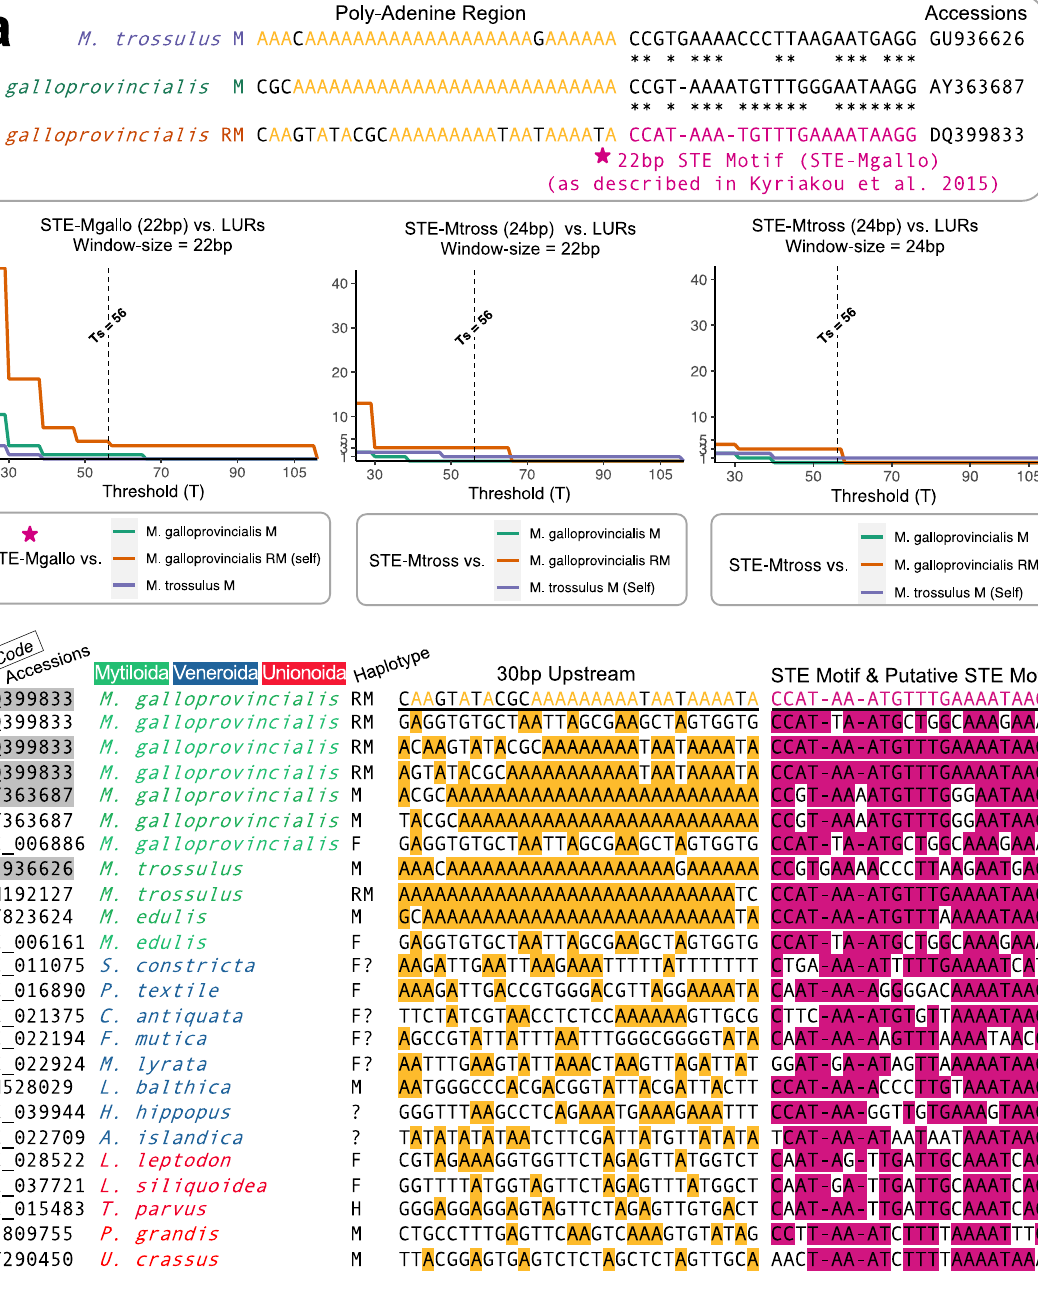
Figure 1. ( a ) Known sperm transmission elements (STEs) from Kyriakou et al. [10]. ( b ) Calibration of the sliding window procedure used to identify novel putative STE motifs. ( c ) Alignments of STE motifs from Kyriakou et al. [10] (accessions shown in shaded grey boxes) versus additional putative STE motifs identified in this study; the characterized STE motif from Kyriakou et al. [10] is marked with a ★ . Nucleotides of the STE motif region were aligned using a MUSCLE algorithm [27], while the 30 bp upstream remains unaligned and simply shows adenine residues. H = Hermaphroditic mitotype, F = Female mitotype, M = Male mitotype, RM = Recently masculinized